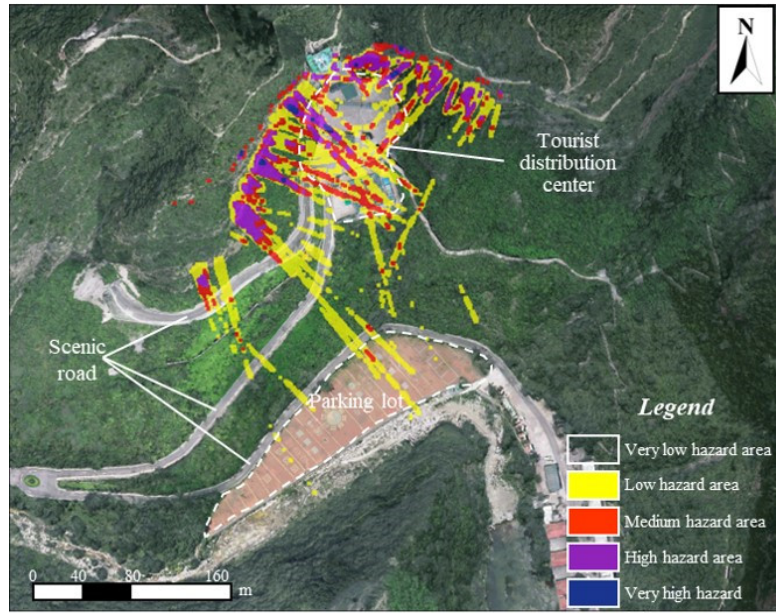
Figure 22. Results of rockfall hazard zoning for the scenic spot in Sky City. The cliff wall at the scenic spot in Sky City is a natural geological relic with great ornamental value. Large unstable rock blocks have been removed from the region near the cliff elevator. However, to preserve the view of the cliff face, only localized areas are protected with shotcrete (Figure 19), which does not provide sufficient protection for the tourist activity area. To preserve the ornamental value of the cliff, it is recommended to set up passive protective nets to intercept the falling rock blocks above the gentle slope at